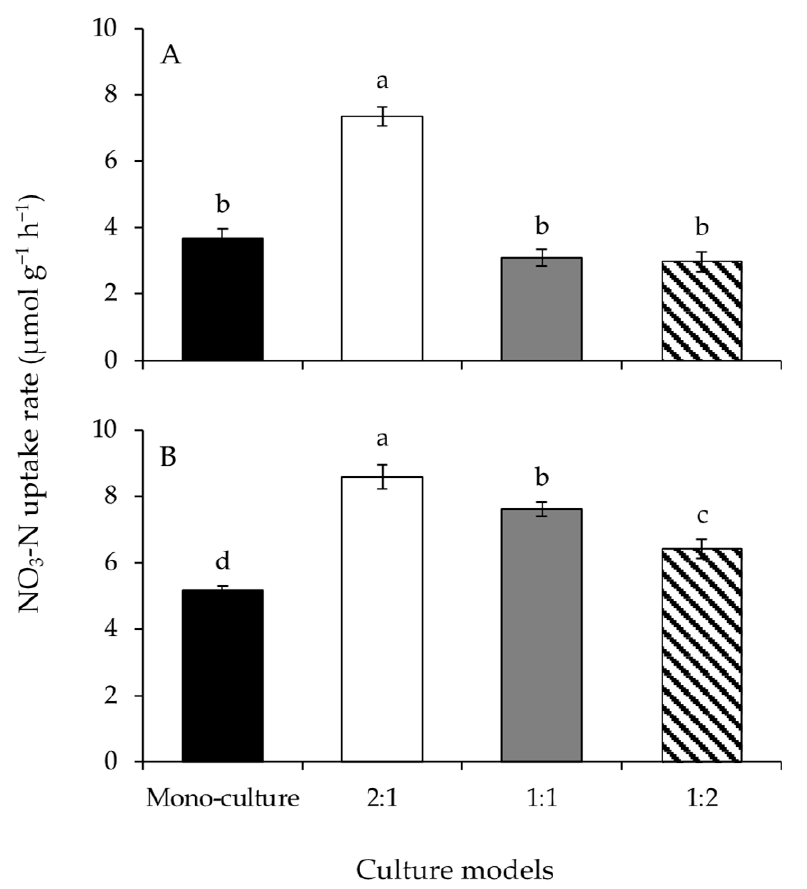
Figure 3. The NO 3 -N uptake rates of Gracilariopsis lemaneiformis ( A ) and Sargassum horneri ( B ) cultured for twelve days at mono-culture and co-culture with biomass density ratios of 2:1, 1:1, and 1:2. Different lowercase letters represent significant differences ( p < 0.05) among culture models.